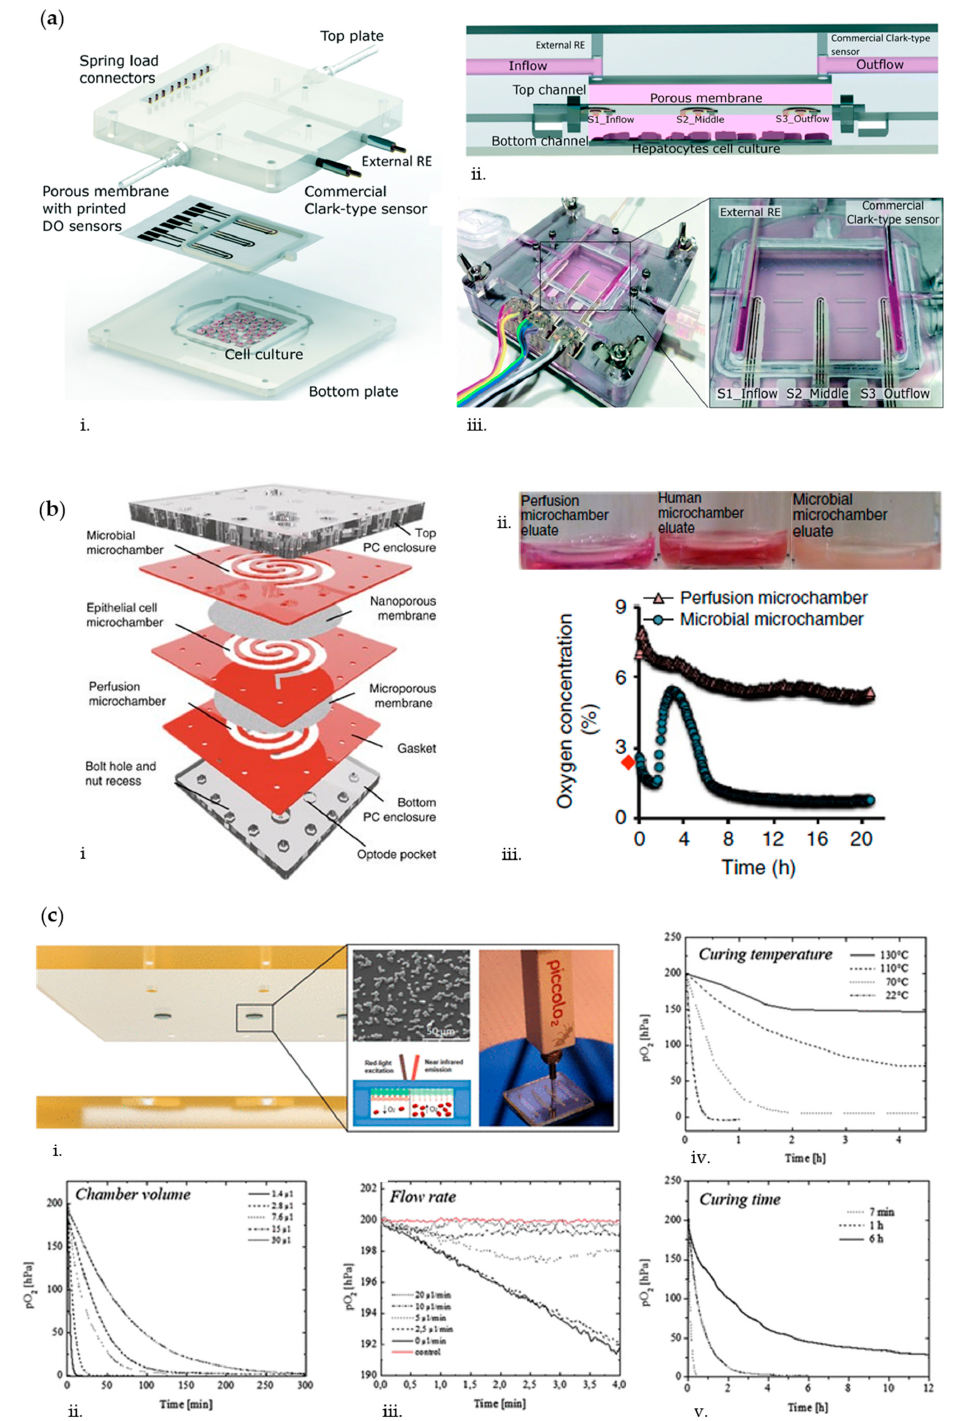
Figure 1. ( a ) Schematic of the compartments composing the ExoLiver (i); cross-section of the bioreactor showing the position of the three sensors (ii); real picture of the ExoLiver with all the fluidic and electrical connections (iii). Adapted from Ref. [58] with permission from The Royal Society of